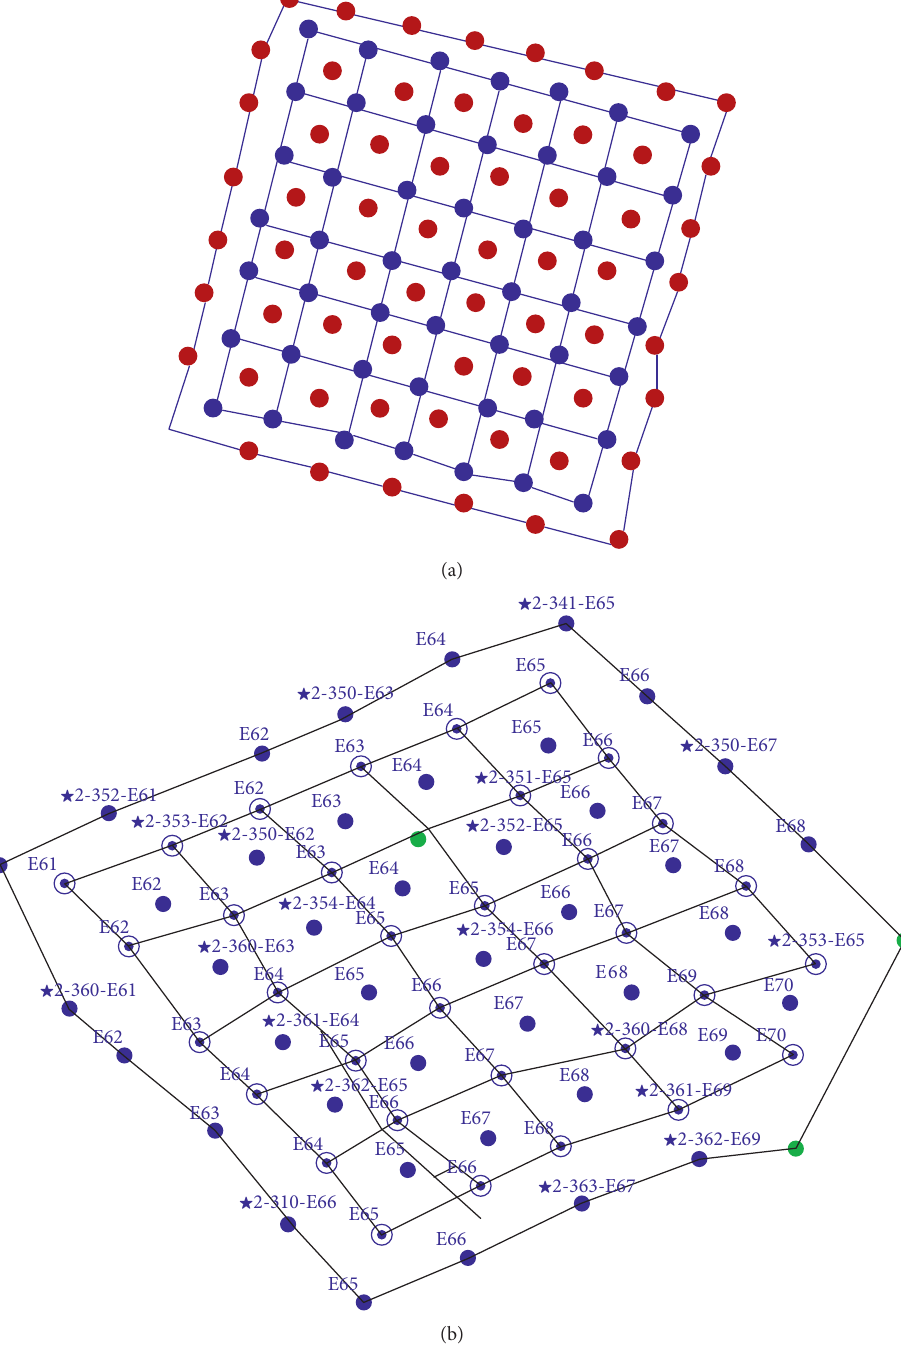
Figure 5: ASP flooding test well pattern [80, 81]. (a) SASP. (b)